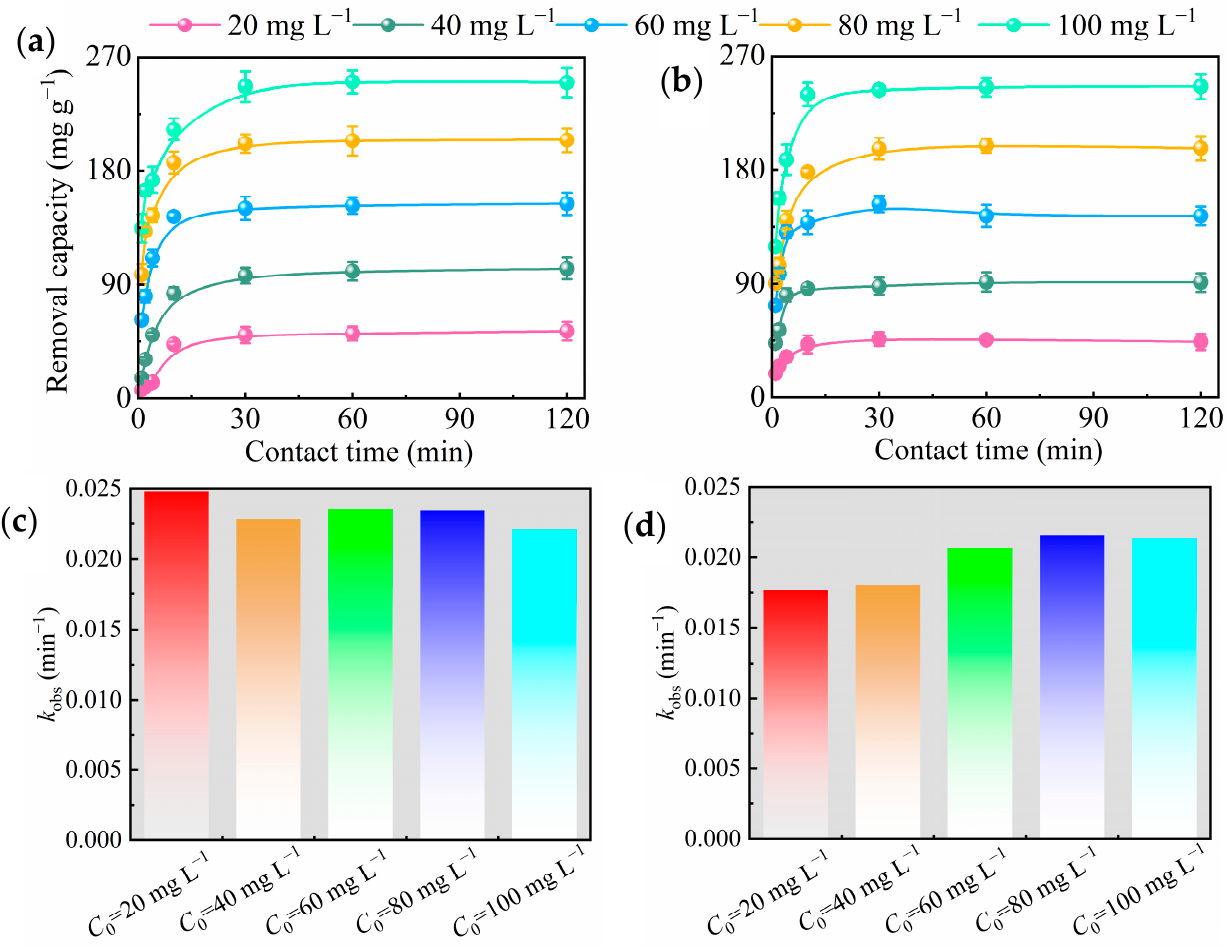
Figure 5. Effect of initial OTC concentration on OTC removal from the RS–FeS/H 2 O 2 ( a ) and RS– EDTA–FeS/H 2 O 2 ( b ) system. Kinetic data of OTC by RS–FeS/H 2 O 2 ( c ) and RS–EDTA–FeS/H 2 O 2 ( d ) system under di ff erent initial OTC concentration (initial pH = 3.00, [H 2 O 2 ] = 6.60 mM).